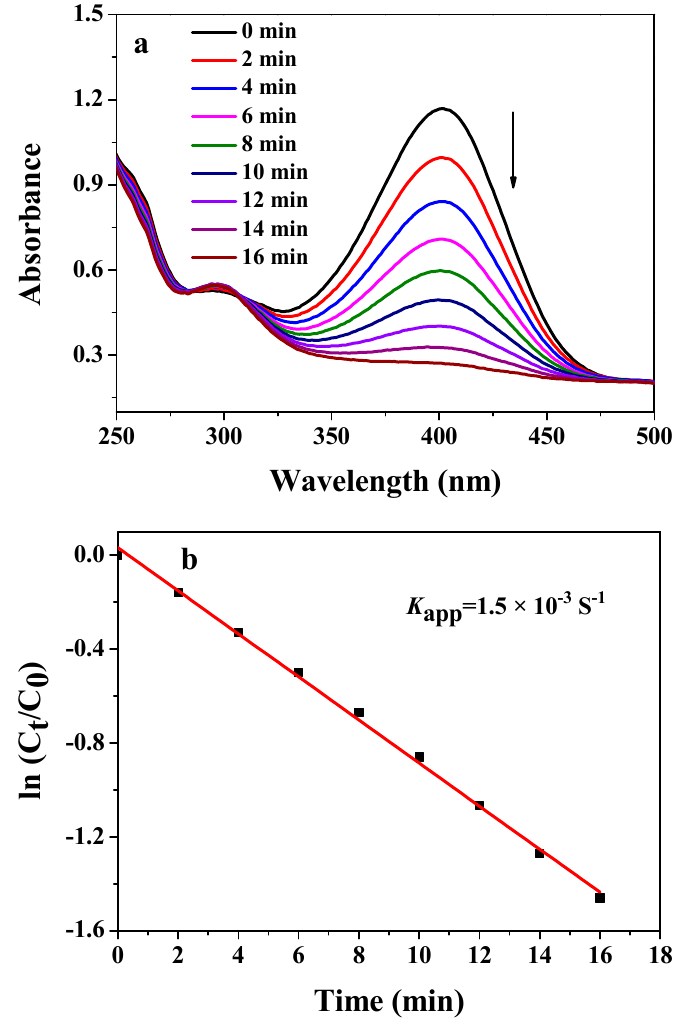
Figure 3. Catalytic behavior of AuNPs in the micelle at R = 4. ( a ) UV-visible absorption spectra during the reduction of 4-NP. ( b ) The corresponding plot of ln(C t /C 0 ) versus time during the reduction of 4-NP.